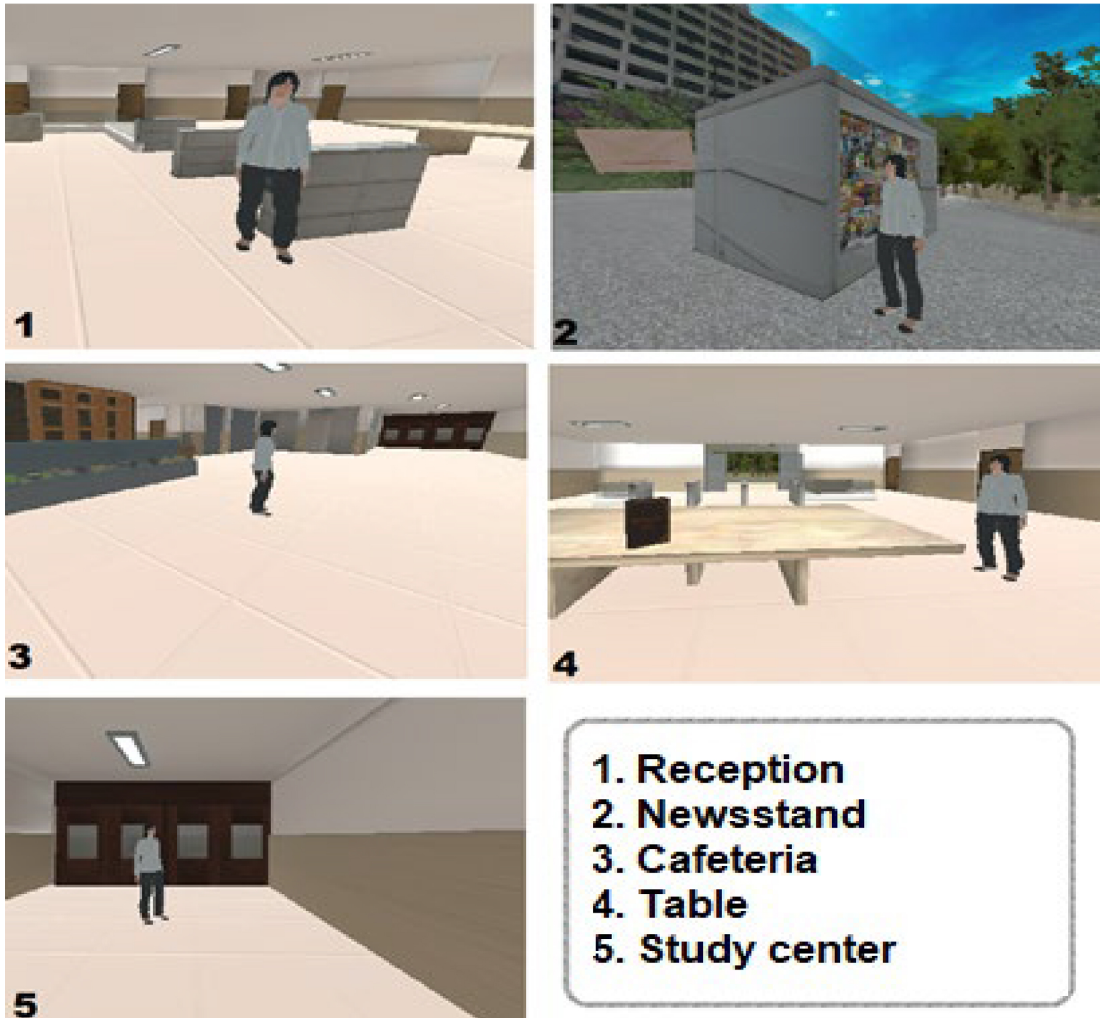
Figure 2. Reproduction of the real environment in virtual